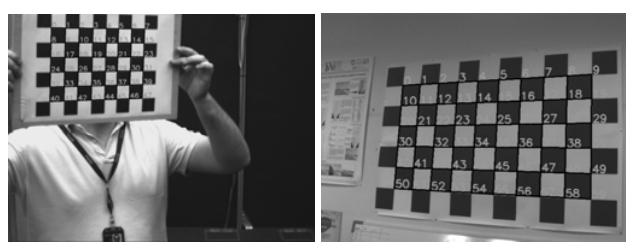
Figure 14. Input points of the calibration